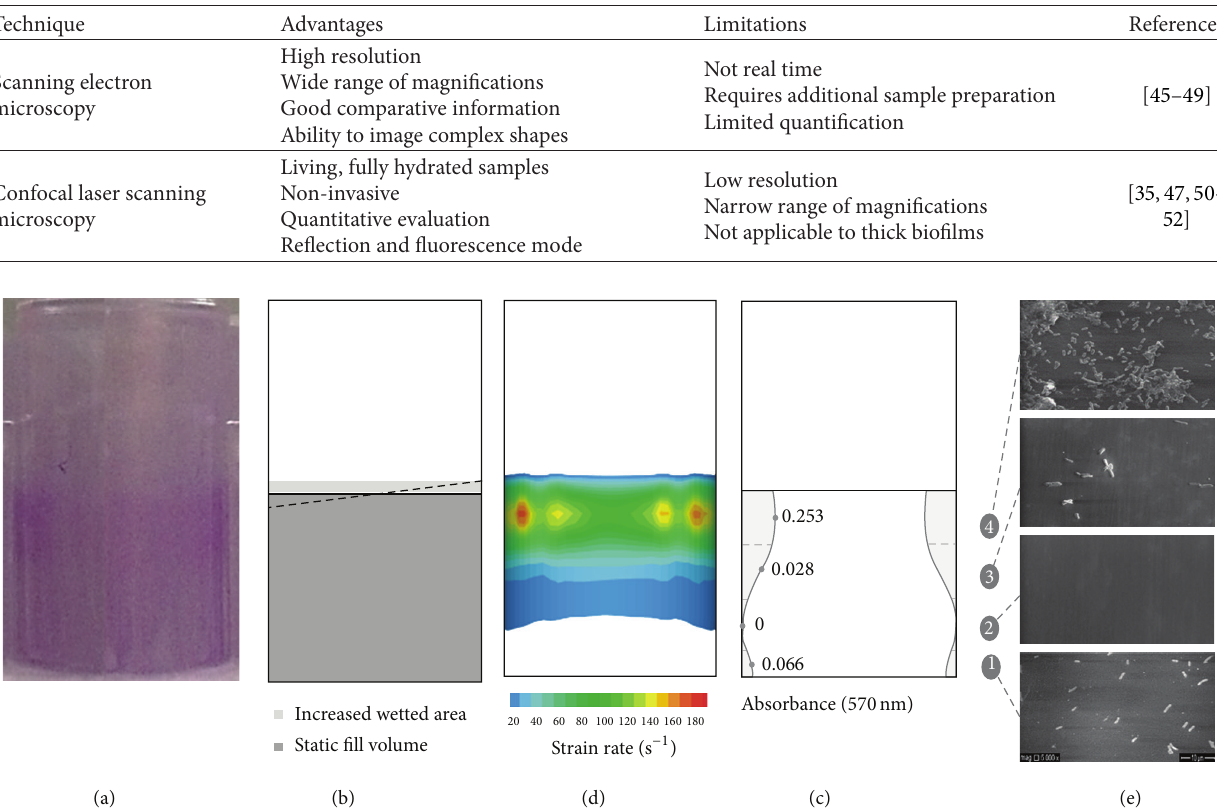
Table 2: Advantages and limitations of scanning electron microscopy (SEM) and confocal laser scanning microscopy (CLSM) on biofilm analysis.